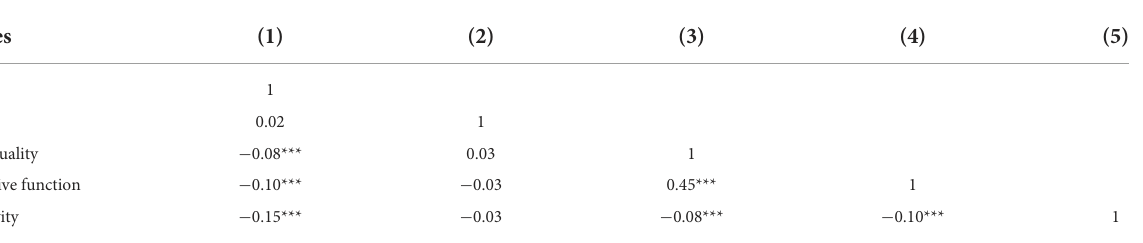
TABLE 2 Correlations among